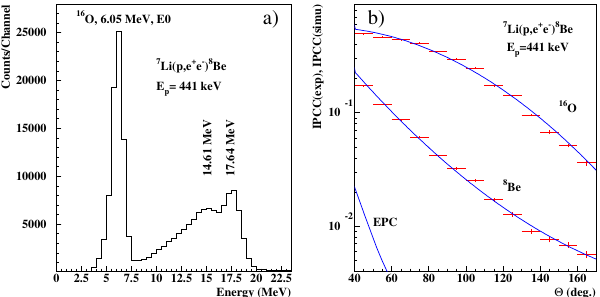
Figure 2. Energy sum spectrum (a) and angular correlation (b) of the e + e − pairs from the 17.6 MeV transition. Full blue curve shows the simulated results, and red points with error bars shows the experimental results